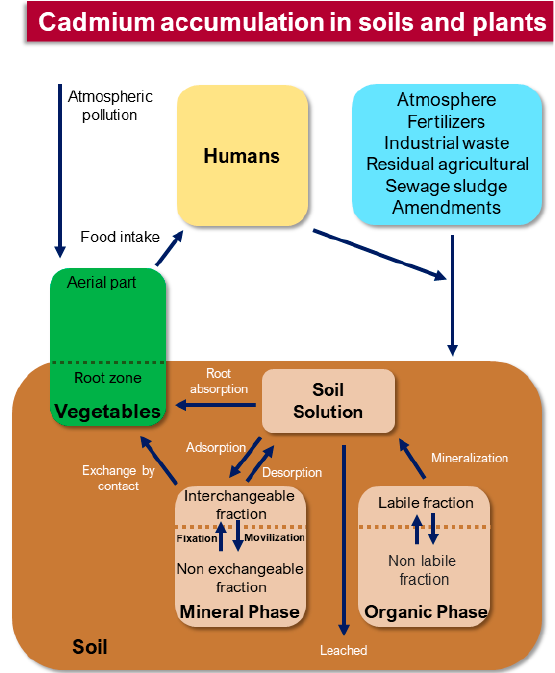
Figure 4. Flow of cadmium in soils and plants and ingestion by humans through plants.